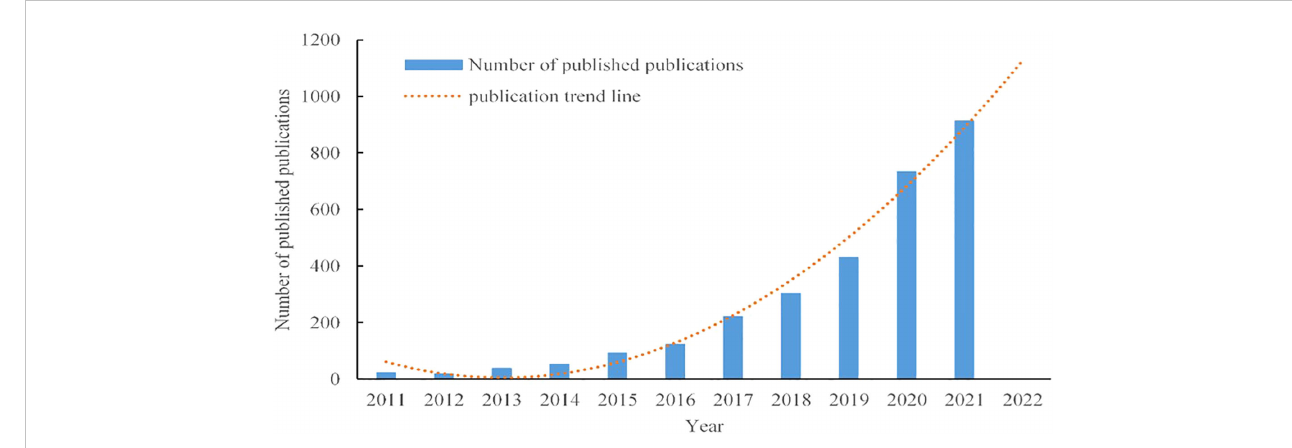
FIGURE 2 Upward trends in the volume of published research on tumor organoids from 2011 to 2021.